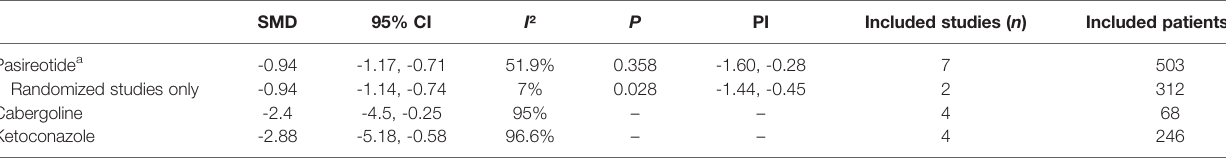
TABLE 2 | Summary of meta-analysis on the reduction of urinary cortisol pre- and post-intervention. SMD 95% CI PI